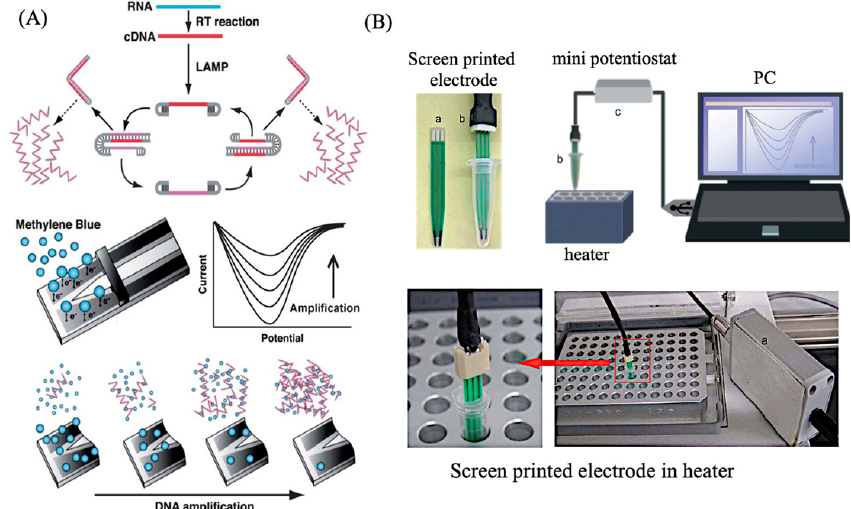
Figure 16. Real-time electrochemical measurements using isothermal gene amplification [20]. ( A ) Scheme of electrochemical detection of LAMP amplified DNA; ( B ) Electrochemical measurement system with screen printed electrodes and heater.